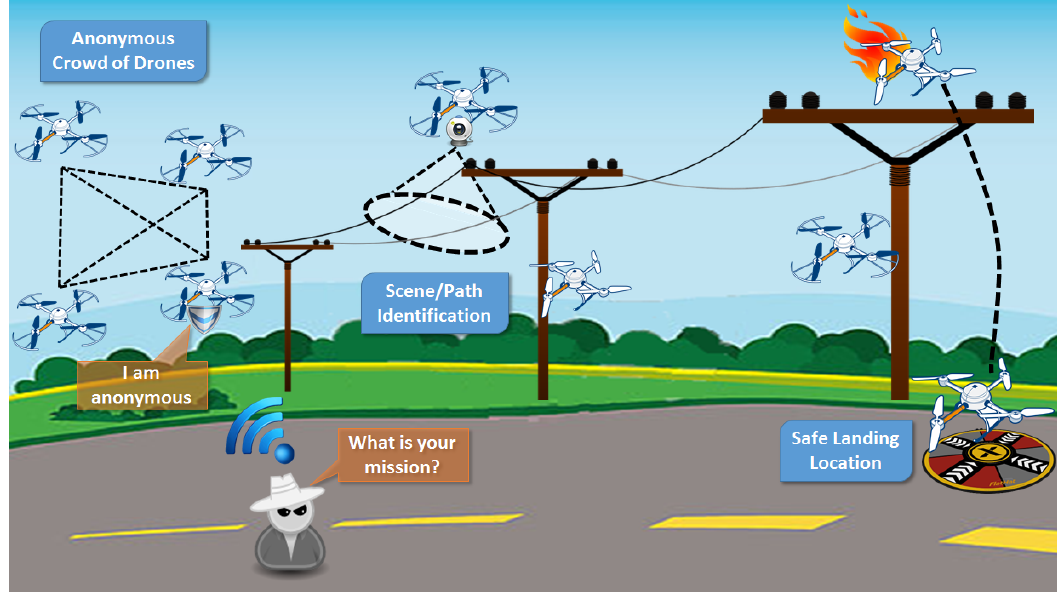
Figure 5. Power-line monitoring